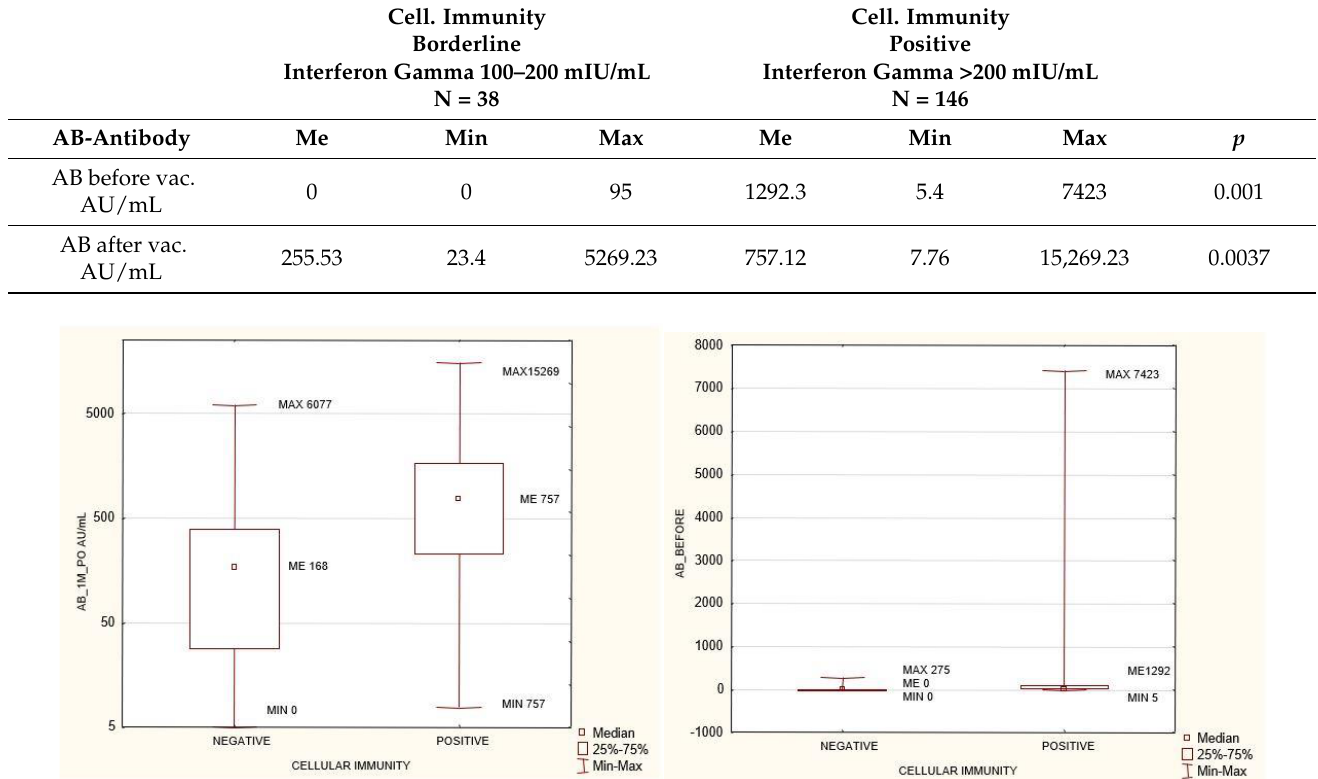
Figure 2. Anti-SARS-CoV-2 antibody levels prior to and after vaccination in groups that developed positive or negative cellular immunity. P = 0.004 and p = 1.77 × 10 – 05 , respectively. Mann-Whitney U test. AB_1M_PO- anti SARS-CoV2 antibody level one month after completed vaccination, CELLU- LAR IMMUNITY after completed vaccination: INFγ concentration >200 mIU/mL positive, <100mIU/mL negative. Table 3. Statistically significant differences between the groups with and without death during the 6-month follow-up after the end of the vaccination